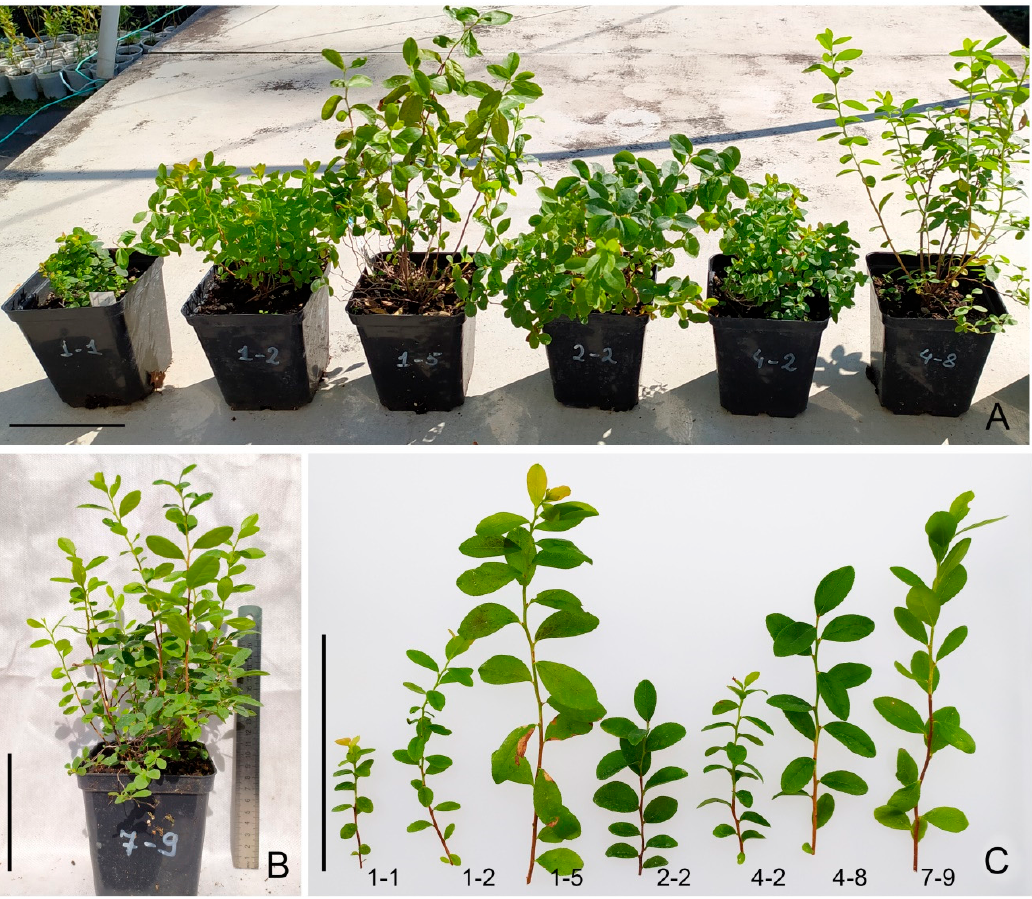
Figure 8. V. uliginosum × ( V. corymbosum × V. angustifolium ) hybrids after 2 years of cultivation: ( A ) V.ul. 8 × ‘NC’ No. 1-1, 1-2, 1-5, 2-2, 4-2, 4-8; ( B ) V.ul. 8 × ‘SC 5-8’ No. 7-9; ( C ) annual shoots of No. 1-1, 1-2, 1-5, 2-2, 4-2, 4-8, 7-9. Bar: 10 cm.